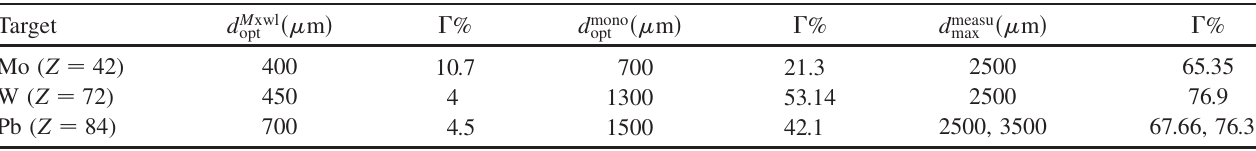
TABLE I. A comparison of the x-ray flux percentage of increase, (cid:1) , at the optimum thickness, d opt , for each electron profile, and the maximum measured thickness, d max , for three targets, ( d is in